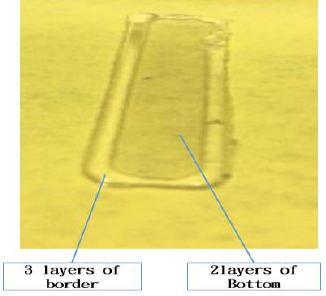
Figure 11. Rapid printing of 3D mold.